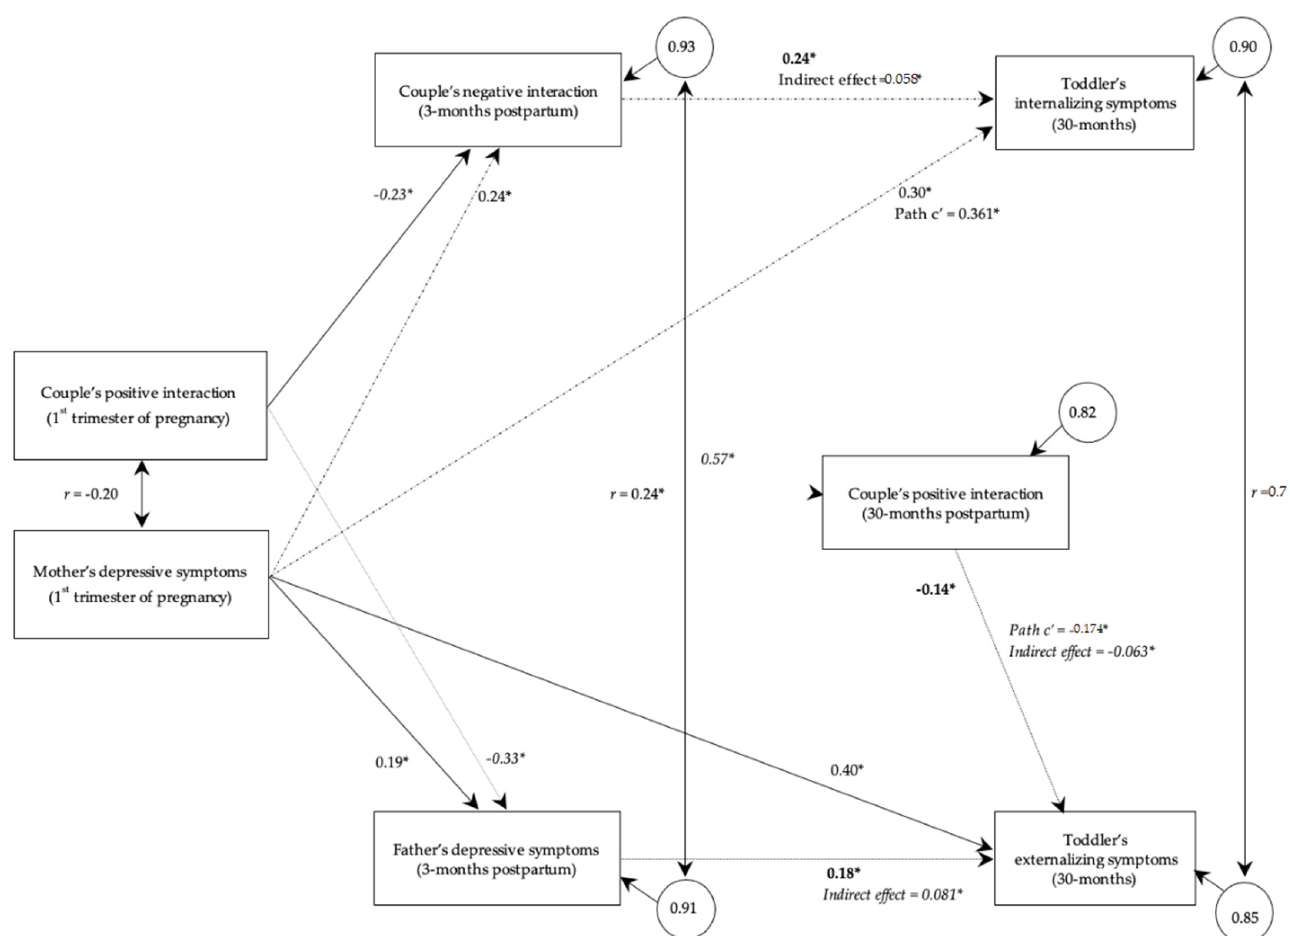
Figure 2. Mediation analyses with standardized values for all parameters. * p <